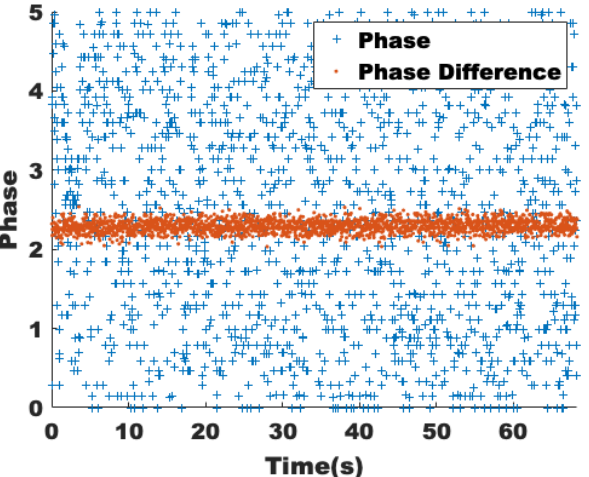
Figure 2. Raw phase and phase difference without human